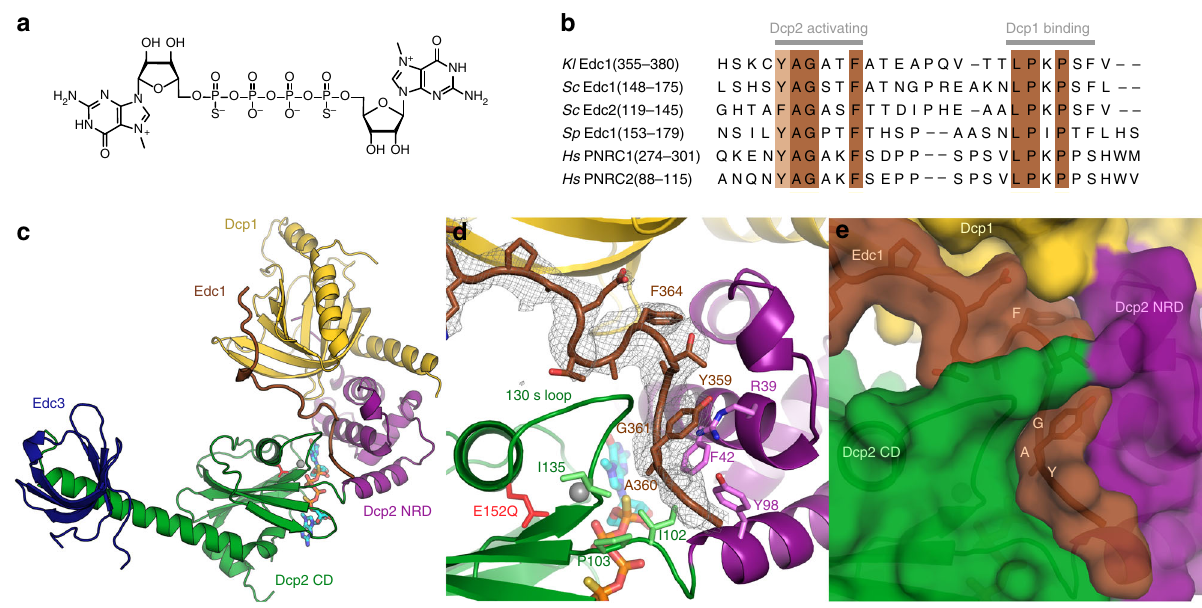
Fig. 1 Structure of the activated decapping complex poised for catalysis. a Structure of the high-af fi nity, two-headed cap substrate analog. b Sequence alignment of Edc1-like coactivator peptides showing the conserved Dcp2-activating and Dcp1-binding motifs; background color intensity is scaled to conservation. c Structure of the substrate analog-bound Kl Edc1 – Dcp1 – Dcp2 – Edc3 complex. Edc1 is brown, Dcp1 is yellow, Dcp2 NRD is purple, Dcp2 CD is green, Edc3 Lsm domain is dark blue, substrate analog is cyan. d Close-up view of the three-way interface between Dcp1, Dcp2 NRD, and Dcp2 CD mediated by the Edc1 YAGxxF Dcp2-activating motif. F o – F c omit map for the Edc1 peptide is shown at 2.5 σ . Sidechains for the Edc1 peptide and nearby conserved residues on Dcp2 are shown as sticks. The catalytic Glu on the Nudix helix, mutated in our structure to Gln, is labeled as E152Q in red. e Surface view of the Edc1 activation motif – Dcp1 – Dcp2 interface, with conserved residues in the activation motif